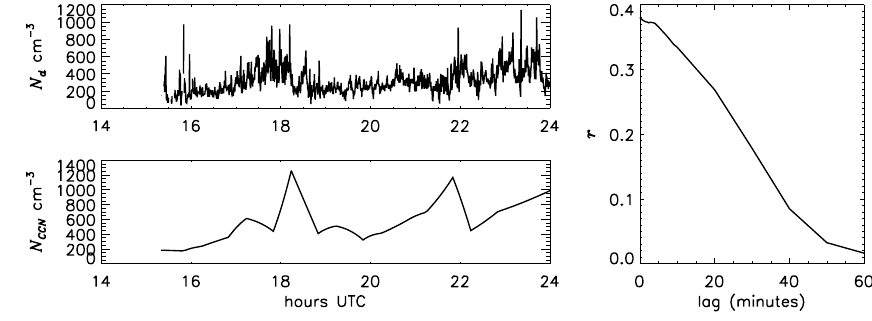
Fig. 8. N d , N CCN , and their lagged cross-correlation from the DOE Pt. Reyes ARM Mobile Facility deployment in 2005.